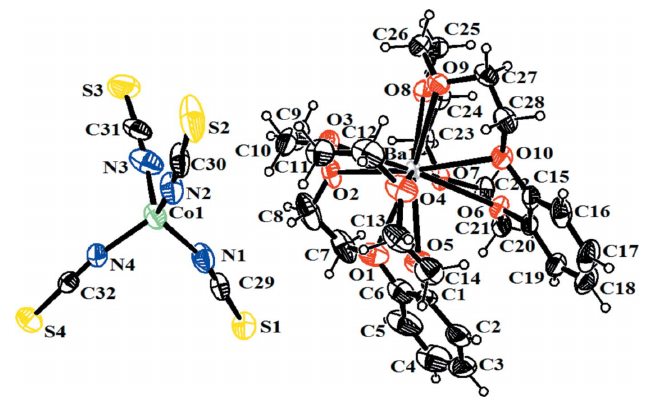
Figure 1 The molecular structure of the title compound with atom labels and 30% probability displacement ellipsoids for non-H